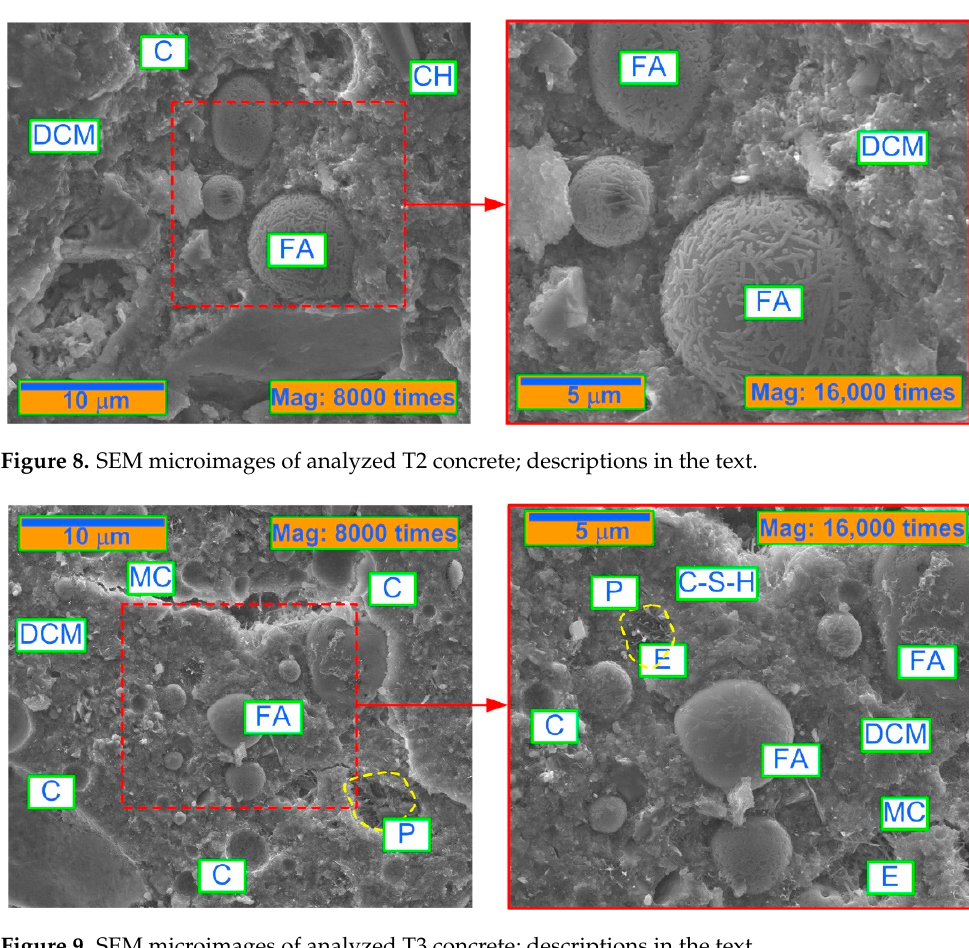
9 of 16 Figure 7. SEM microimages of analyzed T1 concrete; descriptions in the text. In the case of the composite containing only the nS addition at the level of 5%, the effect of reinforcing the cement matrix, as a result of this material modification, was the least noticeable. The structure of this composite was slightly compact. In the concrete of the T1 series, numerous porous areas filled with the ettringite (E) phase, microcracks, and CH phase plates were visible. The matrix inhomogeneity area has been marked in Figure 7 with a yellow dotted frame. Nevertheless, the CH phase was present in a much smaller amount than in the case of REF concrete (Figure 6). This was probably due to the consumption of this weak con- crete phase, i.e., CH, by the reactive nS particles. It was found that the total exothermic heat of the samples containing nS increased significantly in comparison to the mixtures without this SCM [120]. In addition, in the representative images of this composite, DCM was visible in small